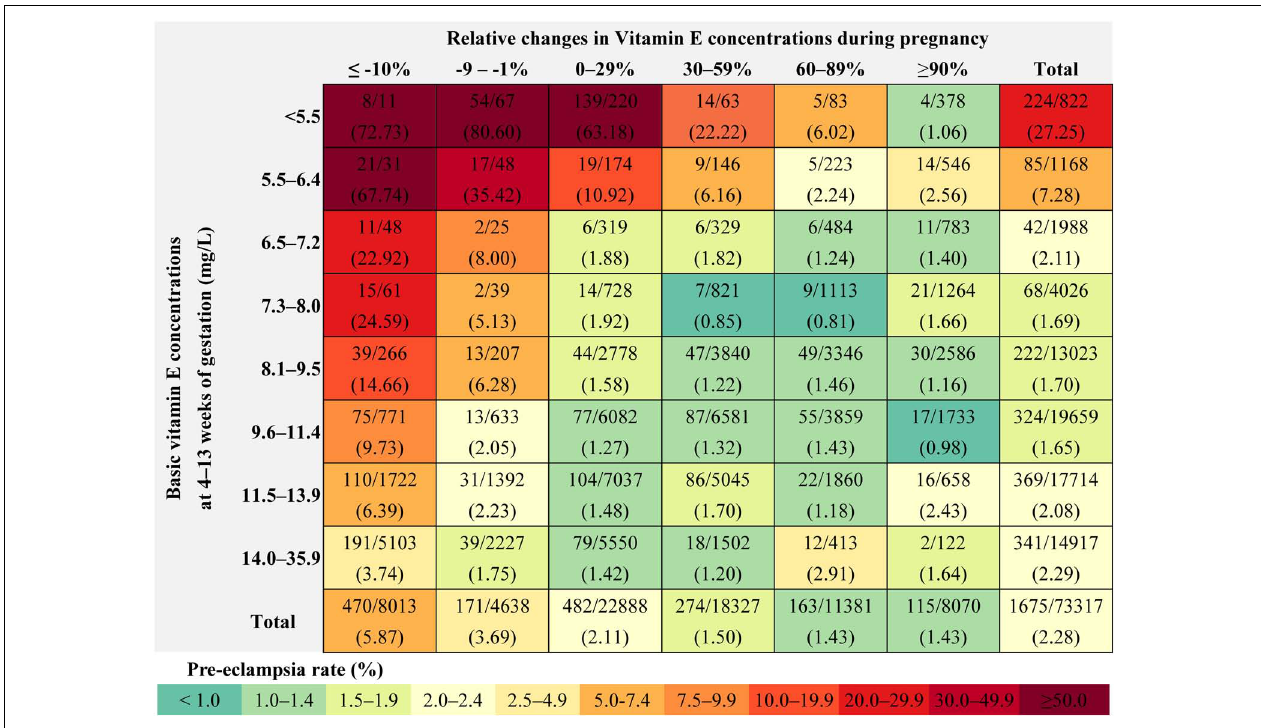
FIGURE 2 | Rate of pre-eclampsia within each combination of the vitamin E concentration categories in the first trimester and the gestational change categories.